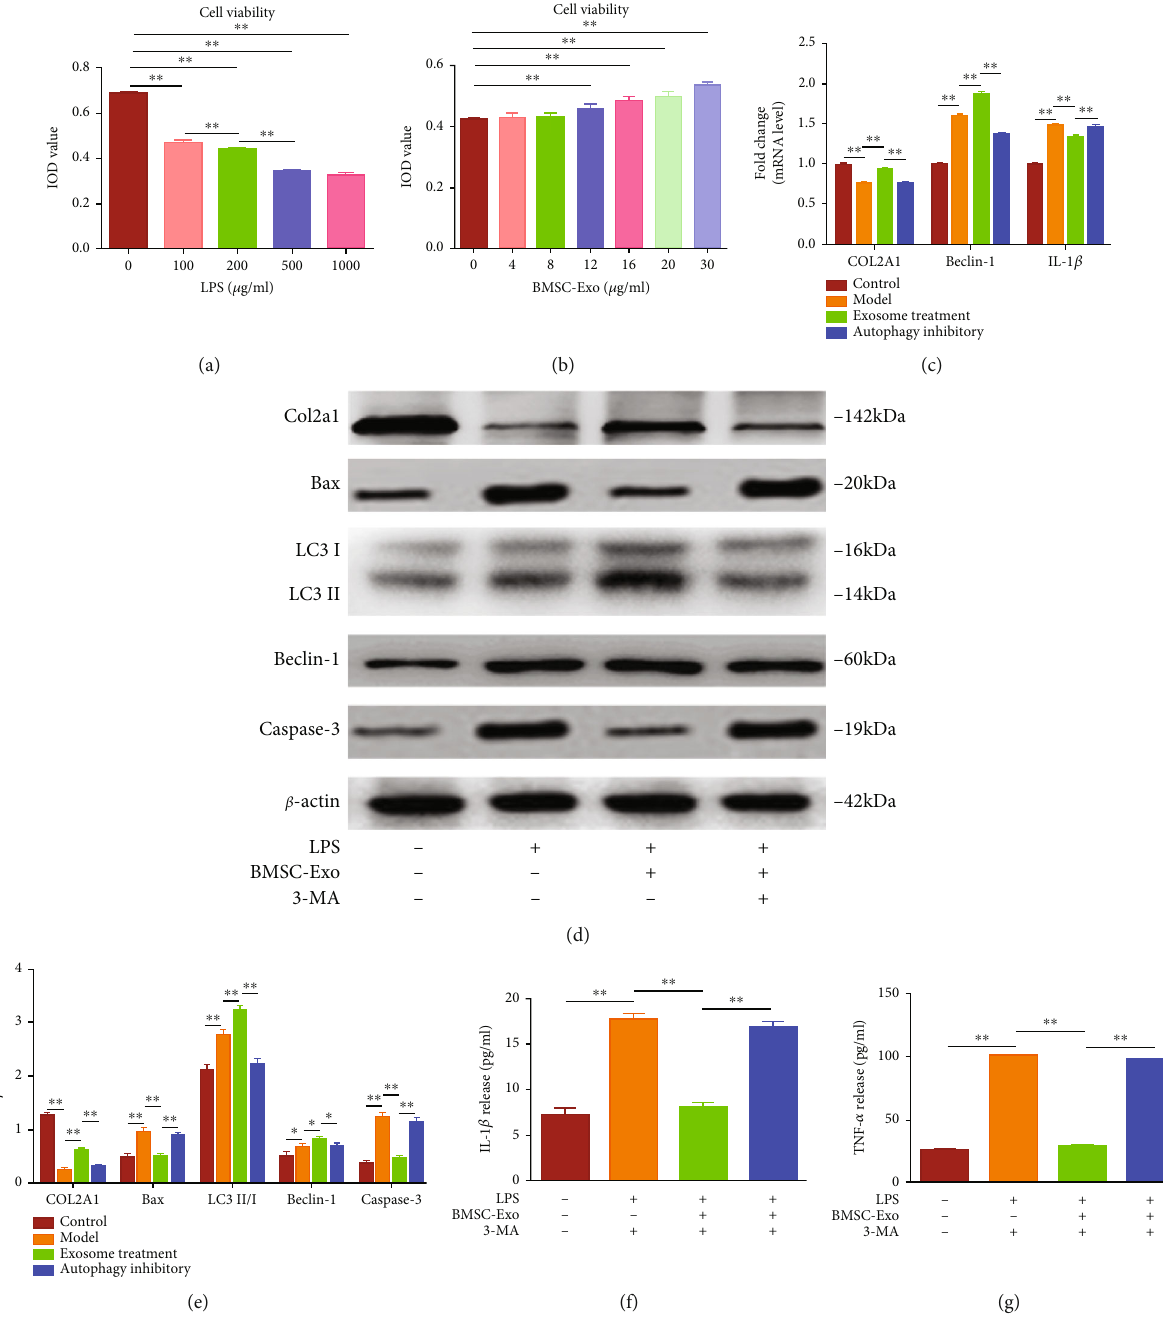
Figure 2: BMSC-Exo inhibits NPC apoptosis by promoting autophagy: (a) the integrated optical density (IOD) of NPCs treated with LPS gradient concentration; (b) IOD of NPCs treated with BMSC-Exo gradient concentration; (c) the mRNA expression of NPCs after incubation with LPS, BMSC-Exo, or 3-MA; (d – g) protein levels of autophagy and apoptosis-related protein (Col2a1, Baxter, LC3, Beclin- 1, and Cleaved Caspase-3) in NPCs after being treated with LPS, BMSC-Exo, or 3-MA. n = 6 . Data are presented as mean ± SD . Statistical analysis was performed with Student ’ s t -test and one-way ANOVA followed by Tukey ’ s multiple comparisons test. ∗ P < 0 : 05 ; ∗∗ P < 0 : 01